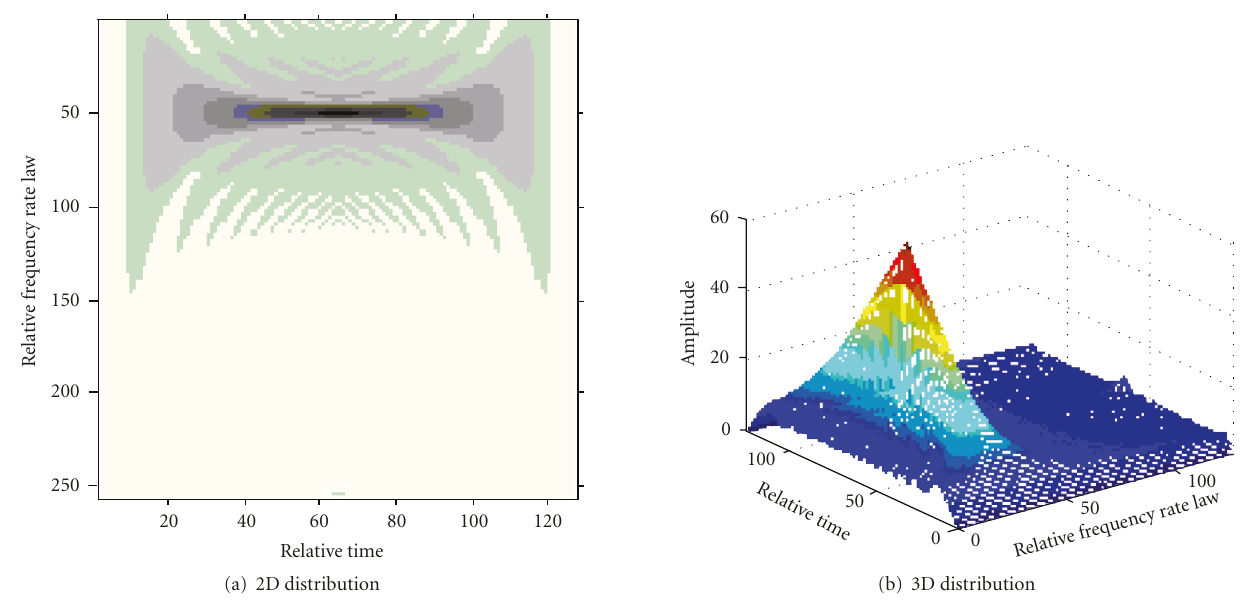
Figure 1: The CPT of a LFM